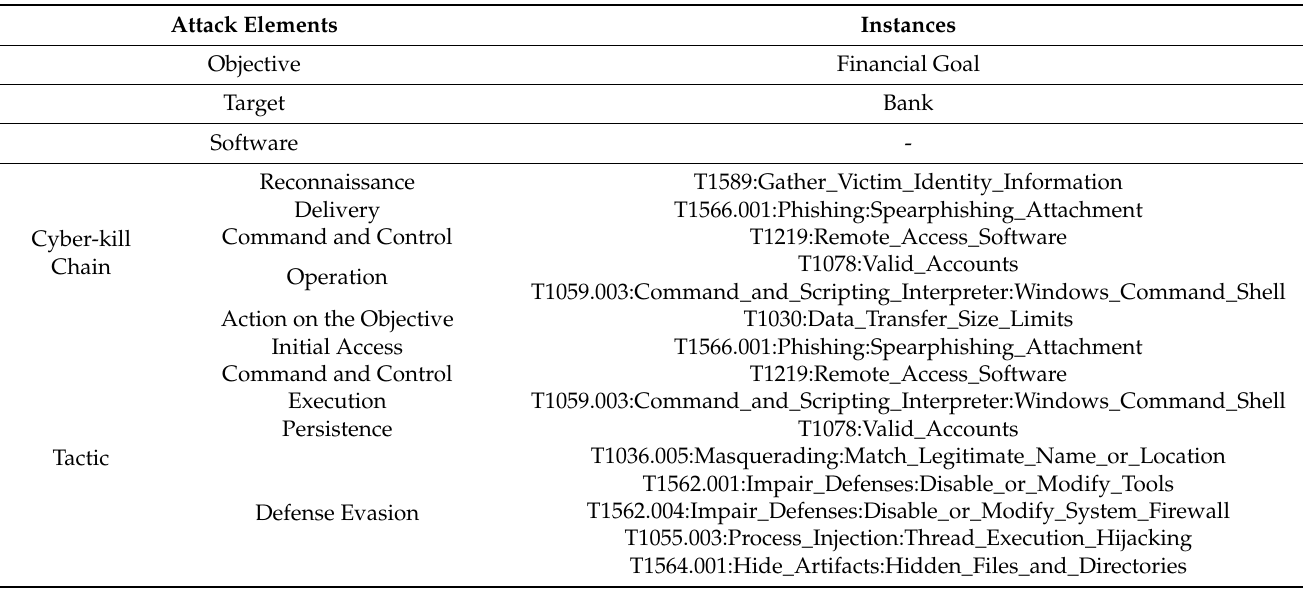
Figure 8. Example scenario for evaluation. Table 7. Result of filling in the attack template.